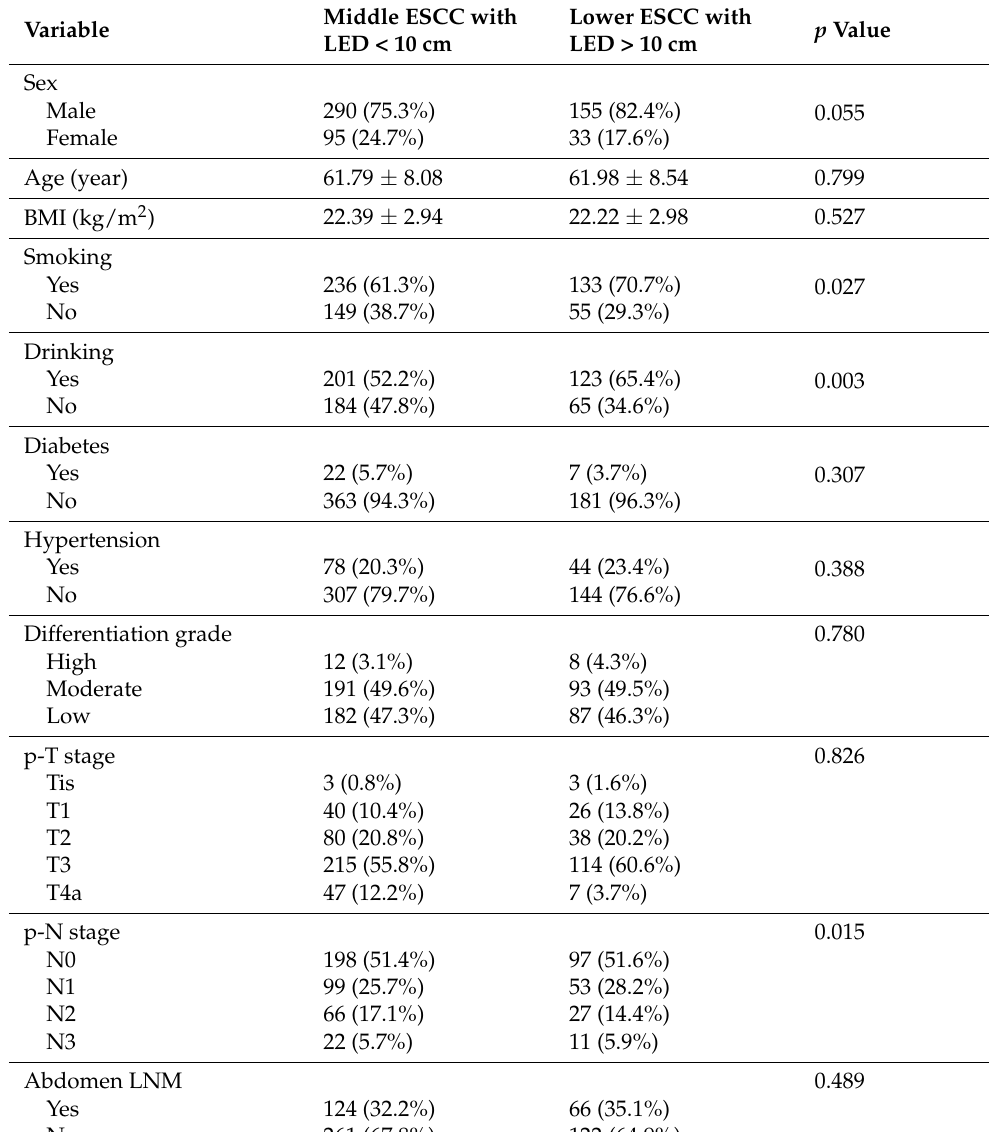
Table 6. Abdominal LNM between middle thoracic ESCC with LED less than 10 cm and lower thoracic ESCC without EGJ